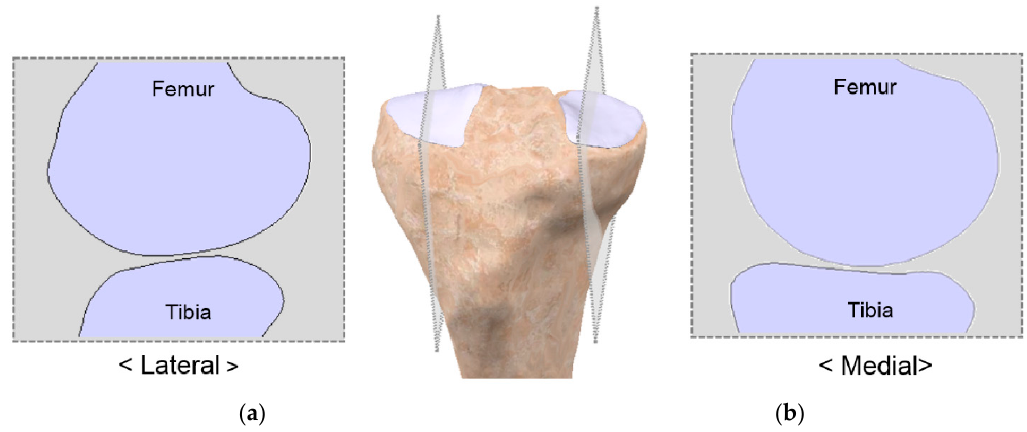
Figure 2. Native knee model showing ( a ) the convex lateral plateau; ( b ) dished medial plateau Figure2. Nativekneemodelshowing( a )theconvexlateralplateau; ( b asymmetry.